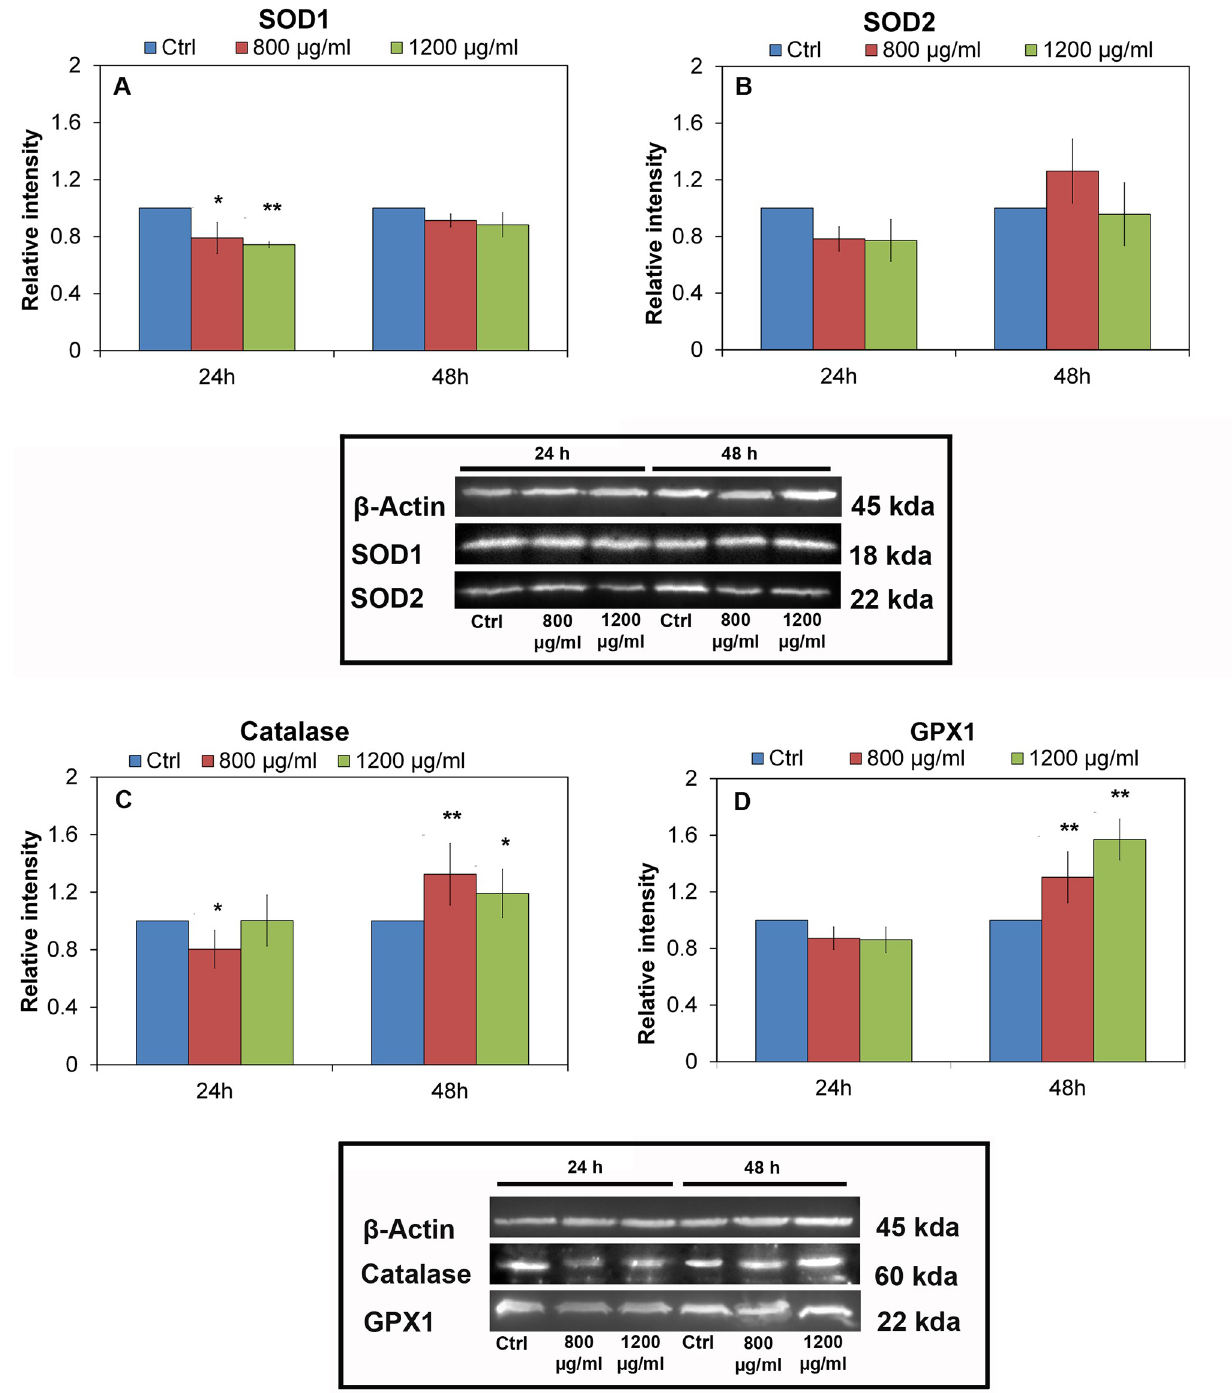
Fig 8. Western Blot analysis. Superoxide dismutase 1( a ) and 2( b ) (SOD1-SOD2) respectively immunoblotting, and Catalase ( c ) and Glutathione peroxidase (GPx1) ( d ) respectively, of extract of HCT-116 cell line in presence of PNPs: 800 μ g / mL and 1200 μ g / mL PNPs concentrations for 24 and 48h, histograms normalized vs ß-actin, Significant values � = p < 0.05; �� = p < 0.005; ��� p = < 0.0005; error bars represent the standard error of the mean.